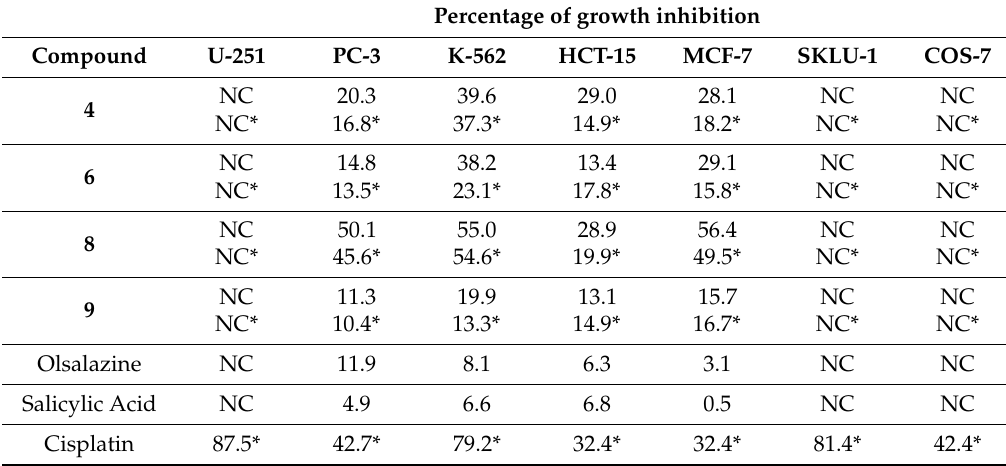
Table 1. Cytotoxic activity of the compounds 4, 6, 8 and 9 at 25 µ M and at 10 µ M*. Percentage of growth inhibition Compound